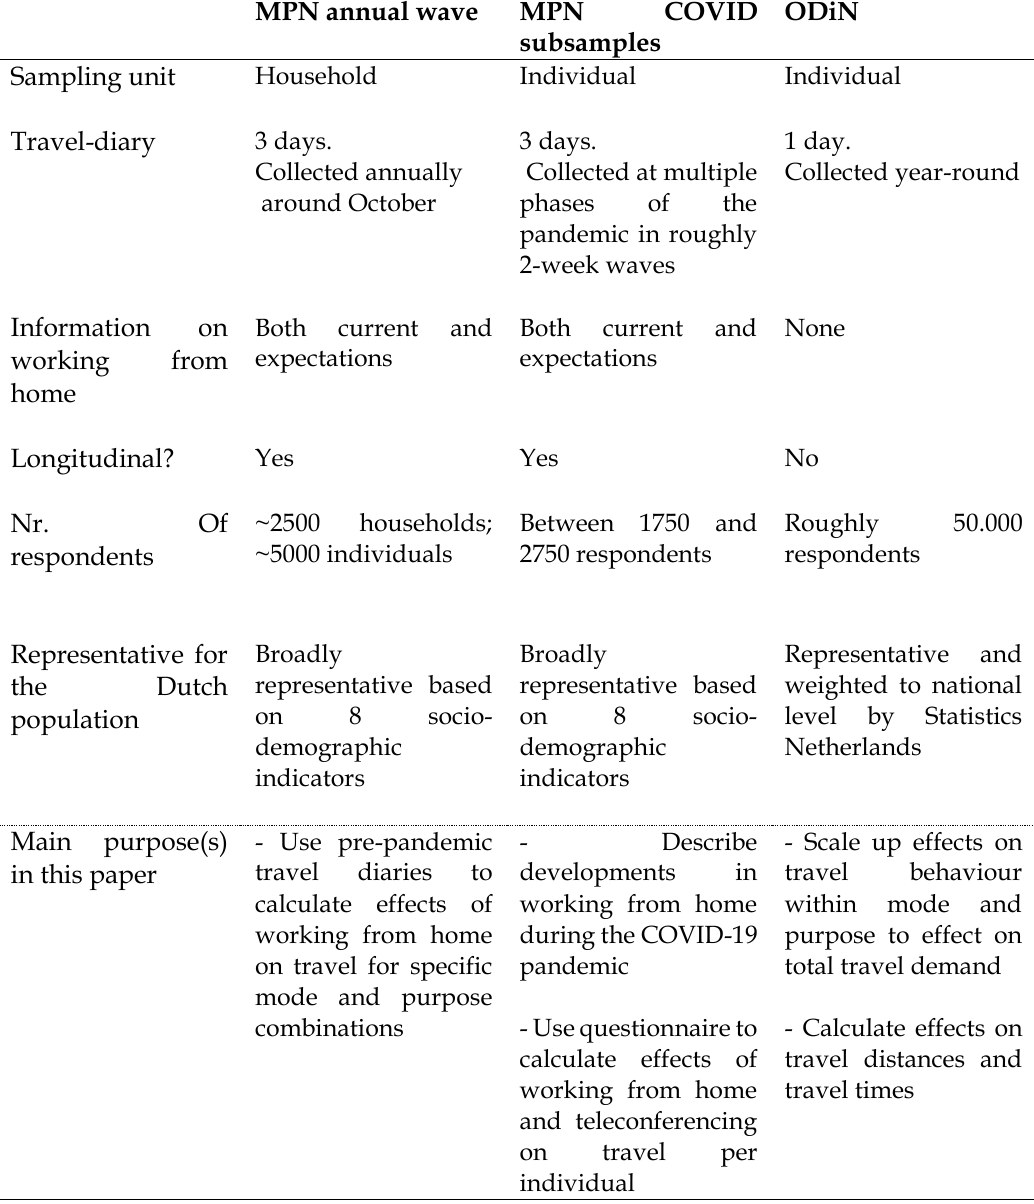
Table 1. Comparison of the data sources used in this study MPN annual wave MPN COVID ODiN subsamples Sampling unit Household Individual Individual